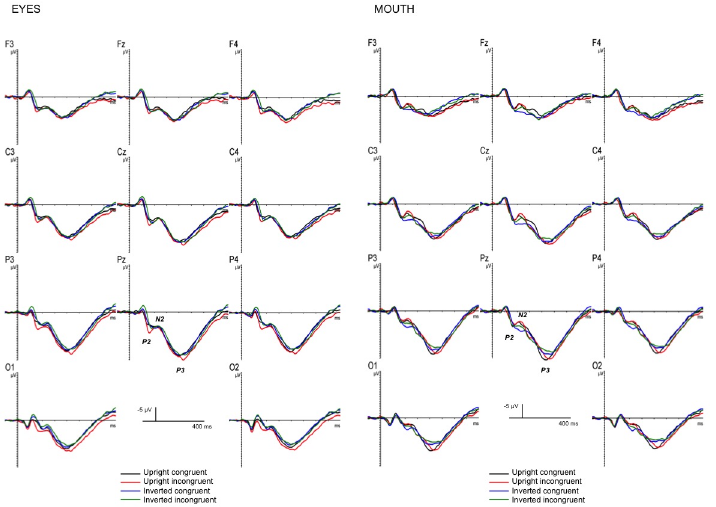
Fig 3. ERP effects of masked priming. Grand-averaged event-related potentials as a function of prime- target congruency, internal features and face orientation.